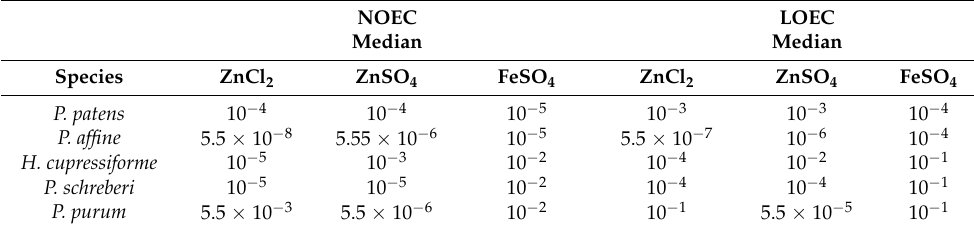
Table 3. Spearman correlation between morphometric parameters and maximum no-effect concen- trations, shown as ρ ( p ). Strong ( ρ ≥ 0.8) and highly significant ( p < 0.01) correlations are highlighted (bold). n = 200 cells.